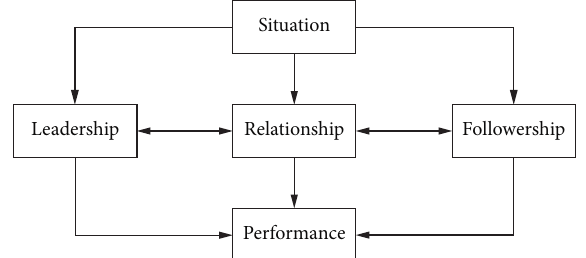
Figure 1: Multifactor relational leadership dynamic system model Table 1: The notations used in this work. Notation